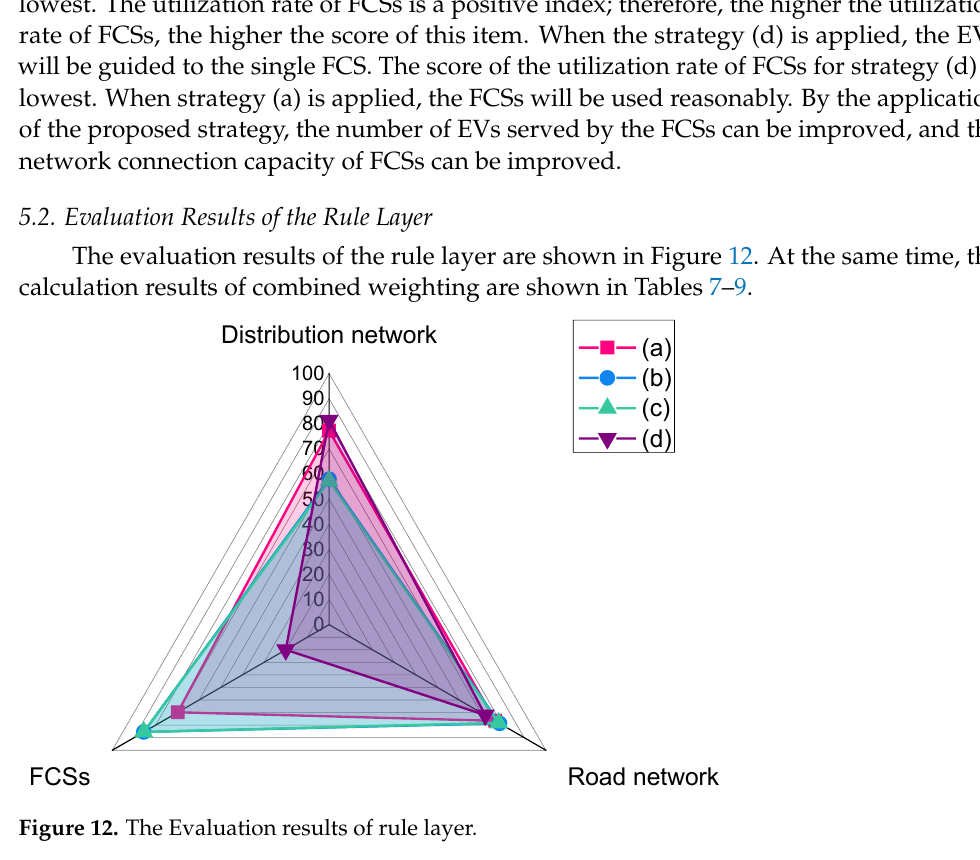
Figure 12. The Evaluation results of rule layer. Table 7. Combined weighting coefficient of distribution network.